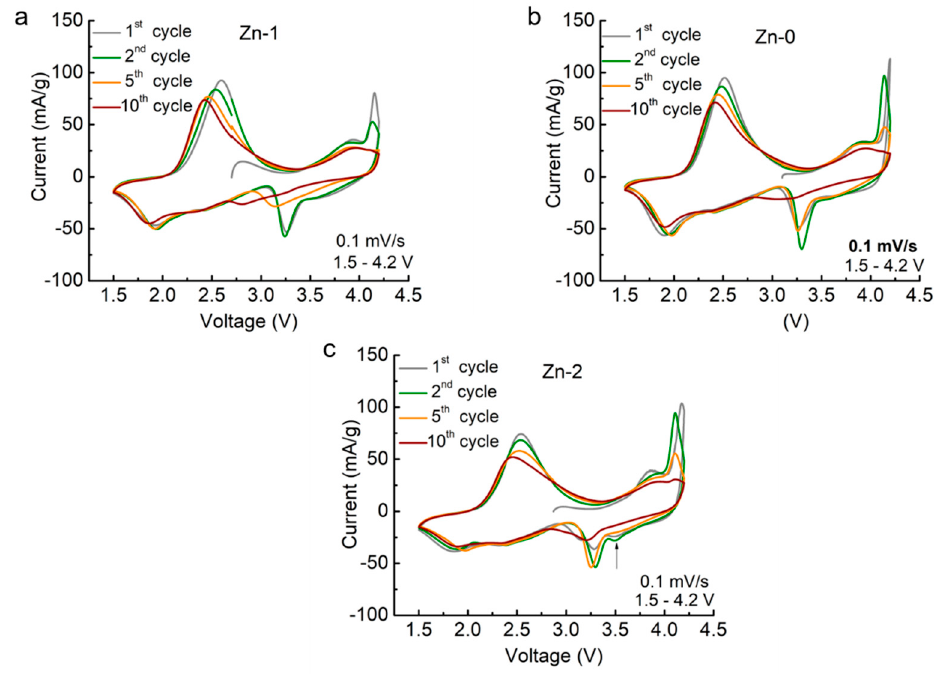
Figure 9. Cyclic voltammetry results of ( a ) Zn-0 ( b ) Zn-1 and ( c ) Zn-2 cathodes in the voltage range of 1.5–4.2 V vs. Na/Na + at a scan rate of 0.1 mV/s.